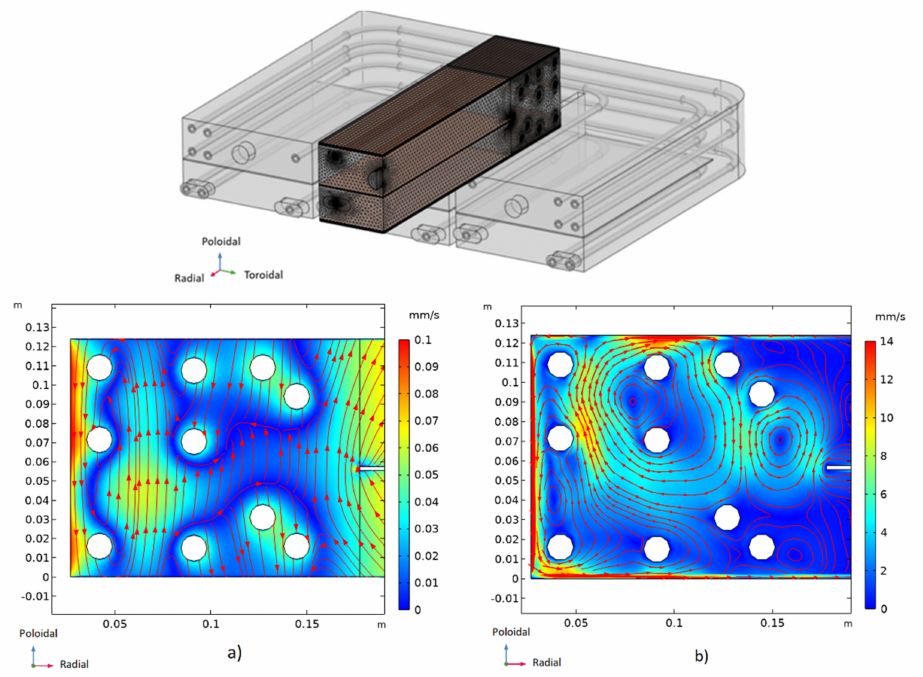
Figure 12. On the top the investigated geometry and the used mesh are shown. Contours of PbLi velocity for ( a ) hydrodynamic ( Ha = 0, Gr = 4.78 × 10 10 ) and ( b ) magnetohydrodynamic ( Ha = 10,830, Gr = 4.78 × 10 10 ) cases [124,125] are displayed on a radial poloidal plane in the middle of the central